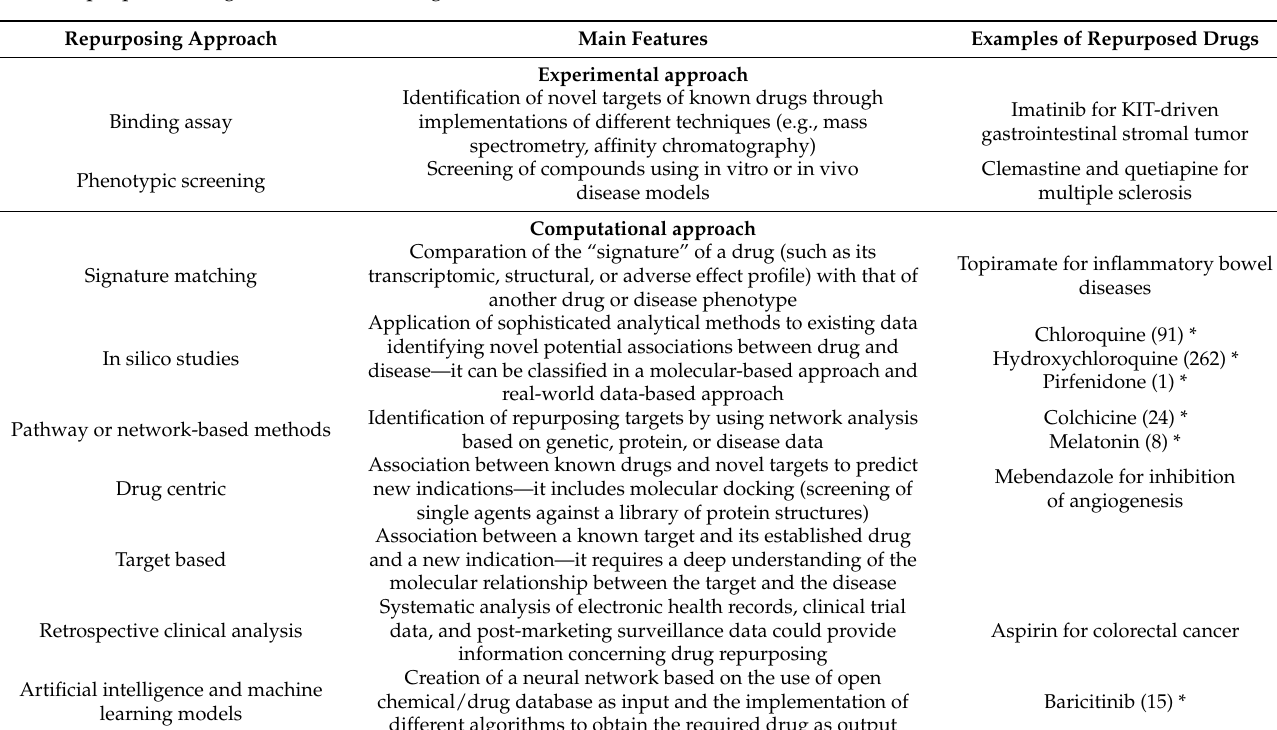
Table 1. Summary of the different approaches to drug repurposing potentially applicable to COVID-19. In bold, examples of repurposed drugs used for the management of